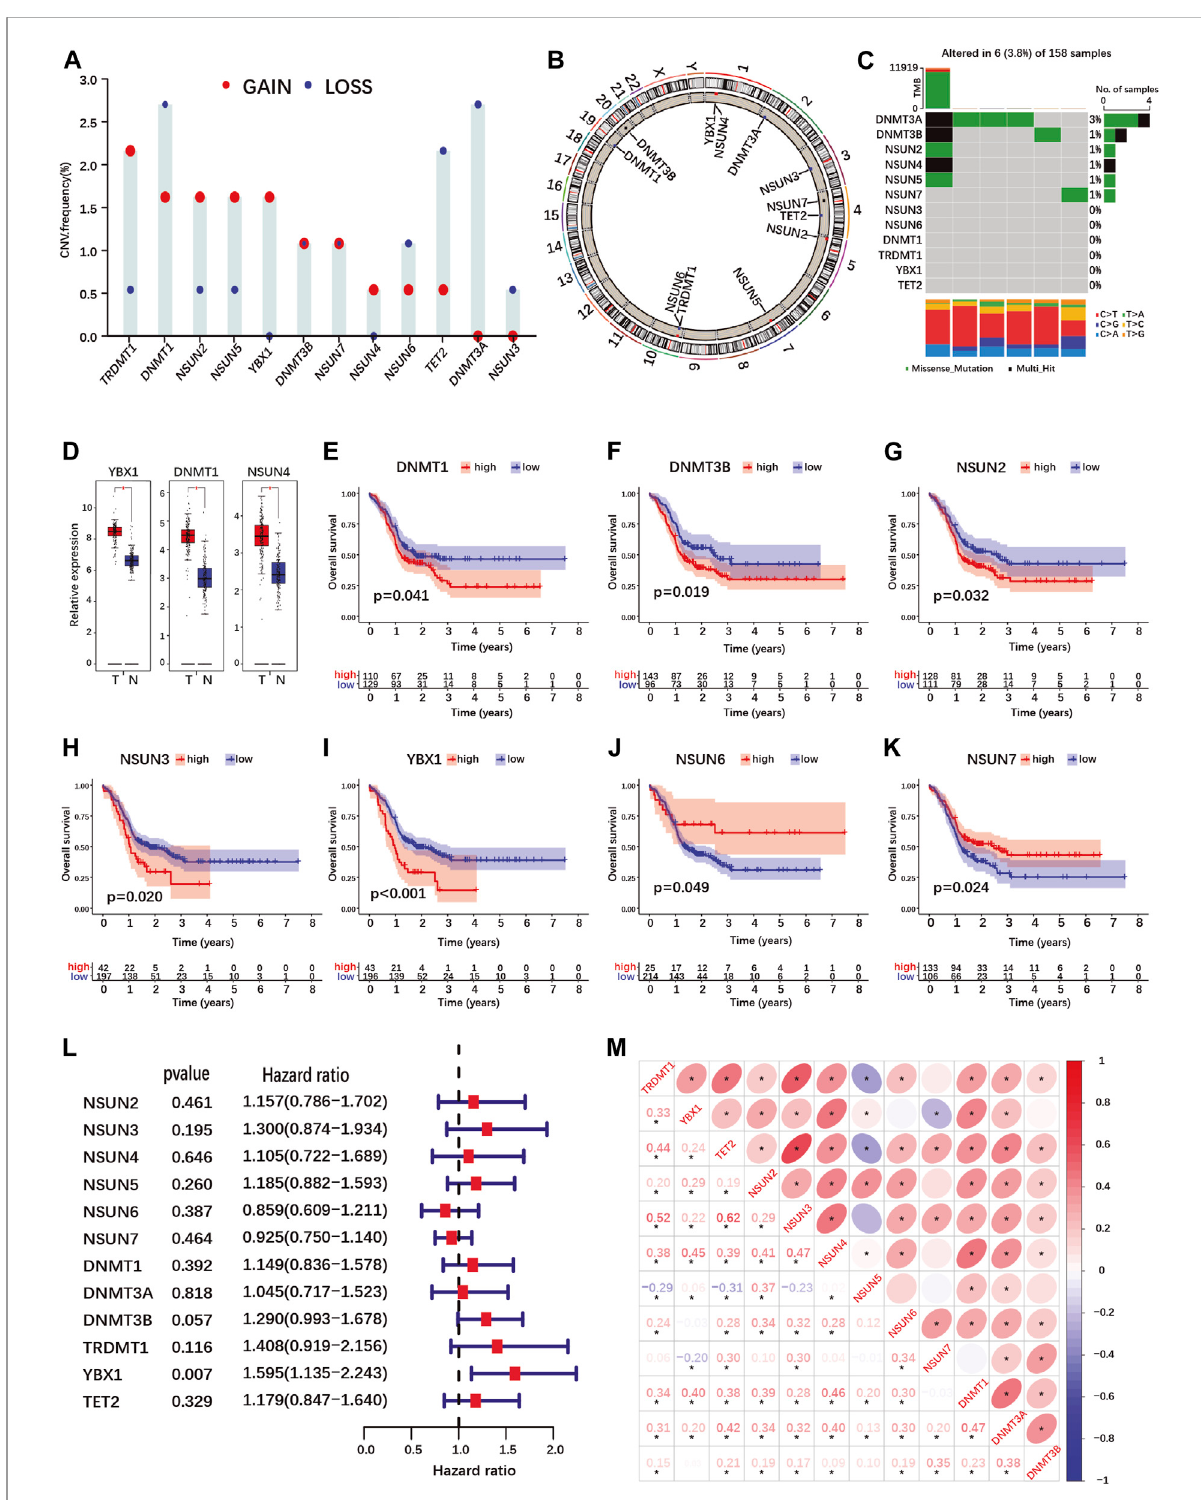
FIGURE 1 Landscape of genetic variation, differential expression, prognosis and correlations analyses of m5C-regulator genes in PDAC. (A,B) Copy number variation (CNV) frequency (A) and location on chromosomes (B) of m5C-regulator genes in the TCGA-PAAD cohort. Red dots represent ampli fi cations, blue dots deletions and black dots equal ampli fi cation and deletion frequency. (C) The somatic mutation status of m5C- regulator genes in the TCGA-PAAD cohort. The upper bar represents tumor mutation burden (TMB), the right bar the number of PDAC patient with a